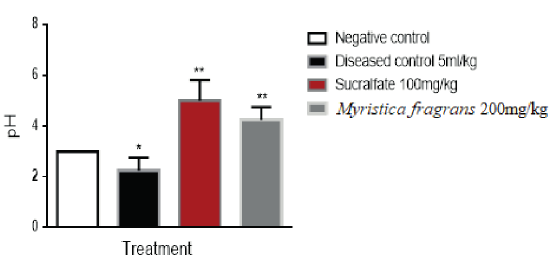
Figure 2 - Determination of the pH of gastric contents from normal control, diseased control (5ml/kg), sucralfate treated (100mg/kg) and Myristica fragrans extract treated (200mg/ kg) group of rats (* P <0.05; compared to control group, ** P <0.05 compared to positive control group;